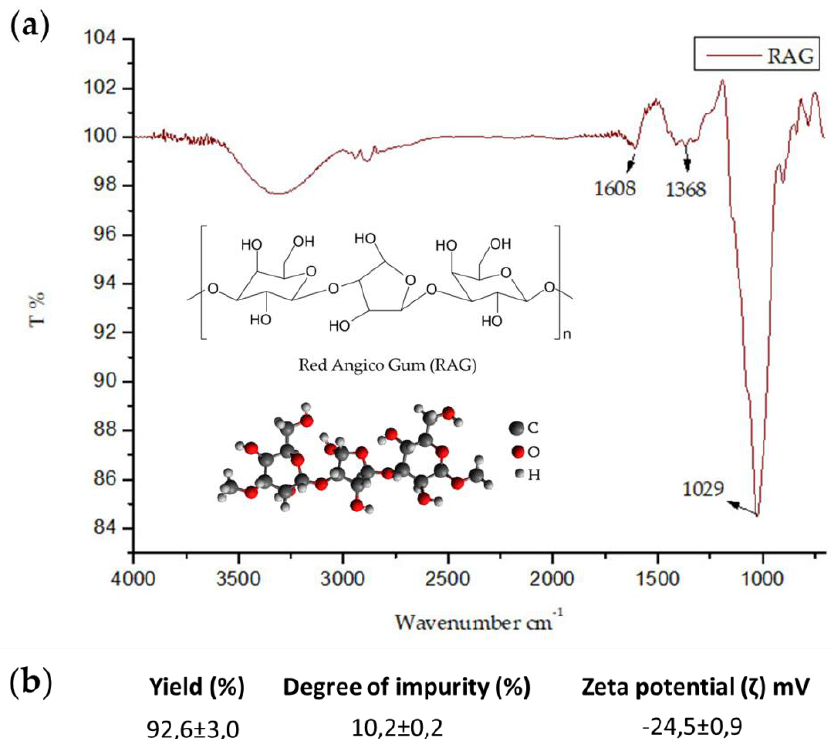
Figure 1. ( a ) FT-IR spectrum of the polysaccharide extracted from the trunk exudate of the red angico tree (RAG) recorded between 700 and 4000 cm −1 in attenuated total reflection (ATR) ( b ) Results of yield, degree of impurity, and Zeta potential (ζ) value.